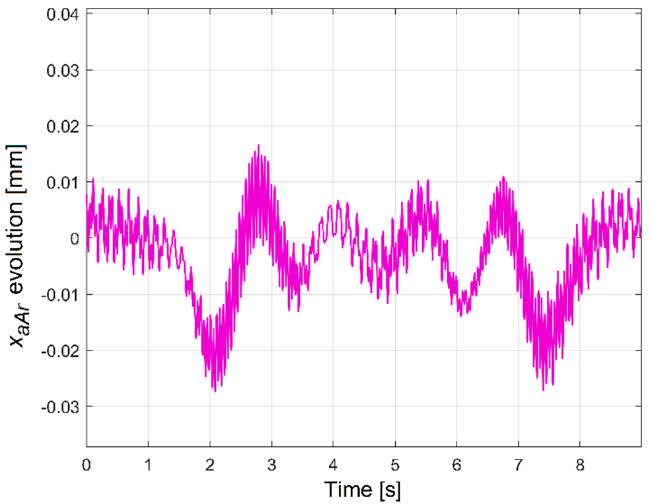
Figure 8. The average evolution x Ar of the residual x r for x -motion.